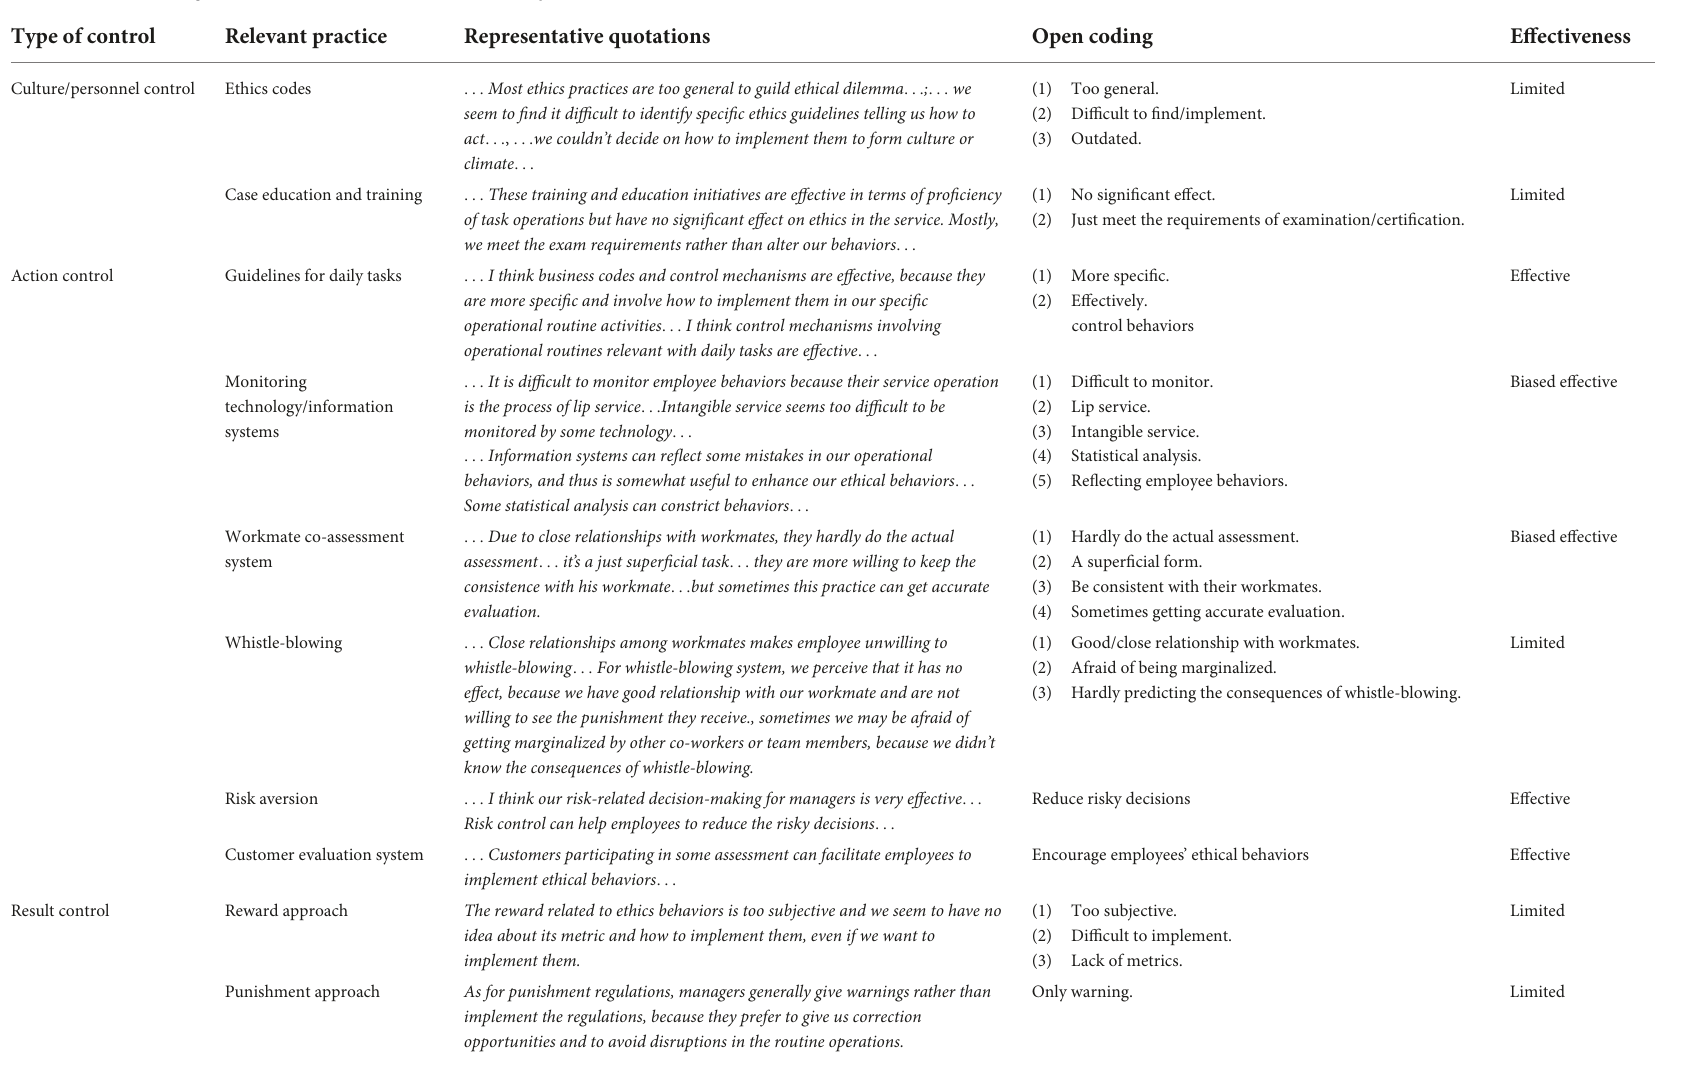
TABLE 3 Content analysis of the effectiveness of the concluded